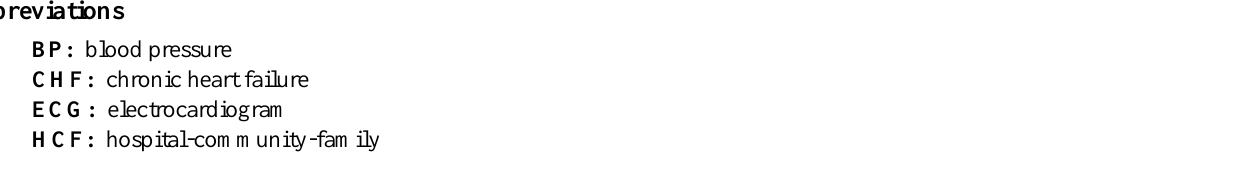
CHF: chronic heart failure ECG: electrocardiogram HCF: